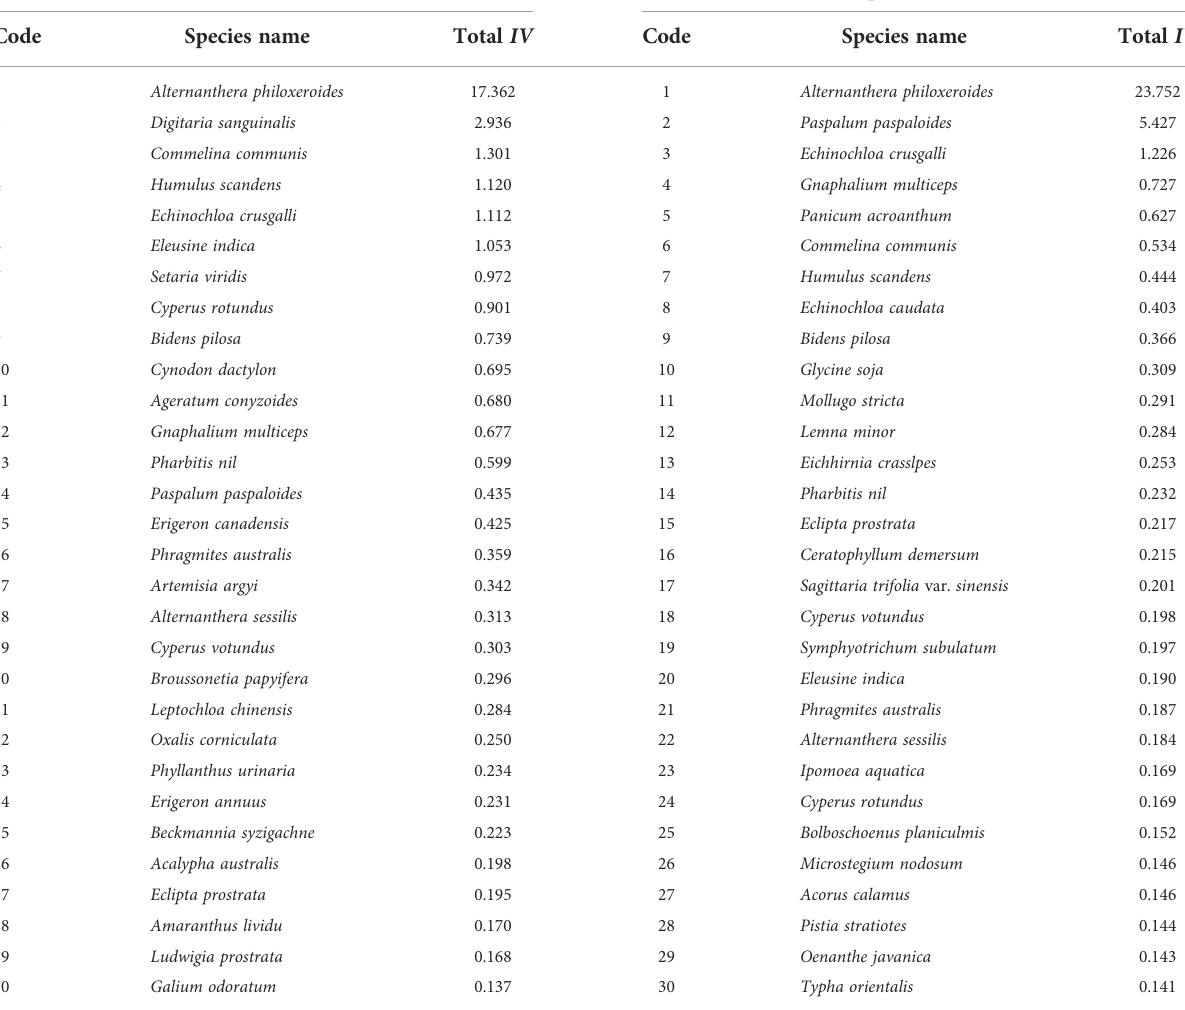
TABLE 1 The total importance values of dominant plant species in terrestrial and aquatic Alternanthera philoxeroides communities. Terrestrial